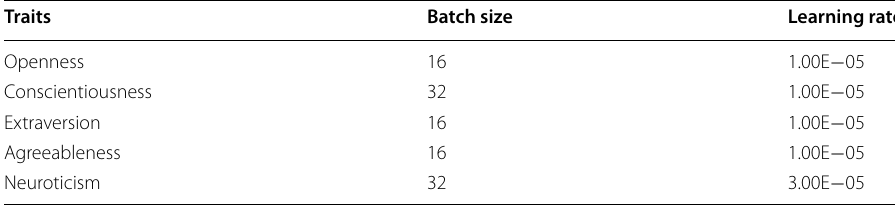
The highest performance value resulting from each of the personalities listed in bold Table 9 Final proposed model best parameters